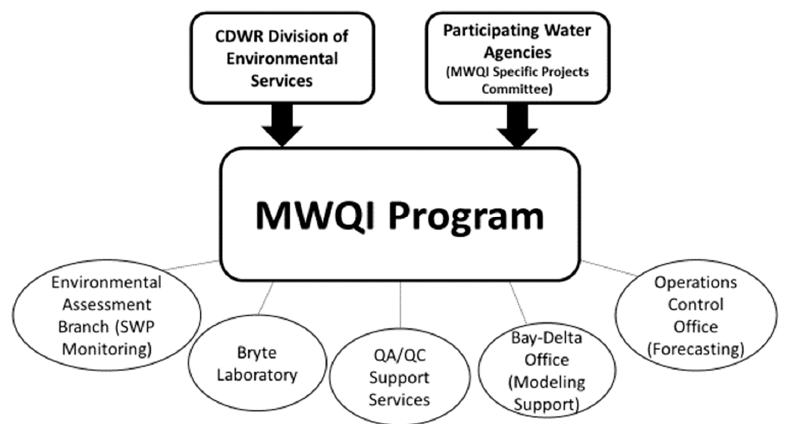
Figure A1. The MWQI program organization structure includes CDWR management, CDWR pro- gram participants, and participating urban water